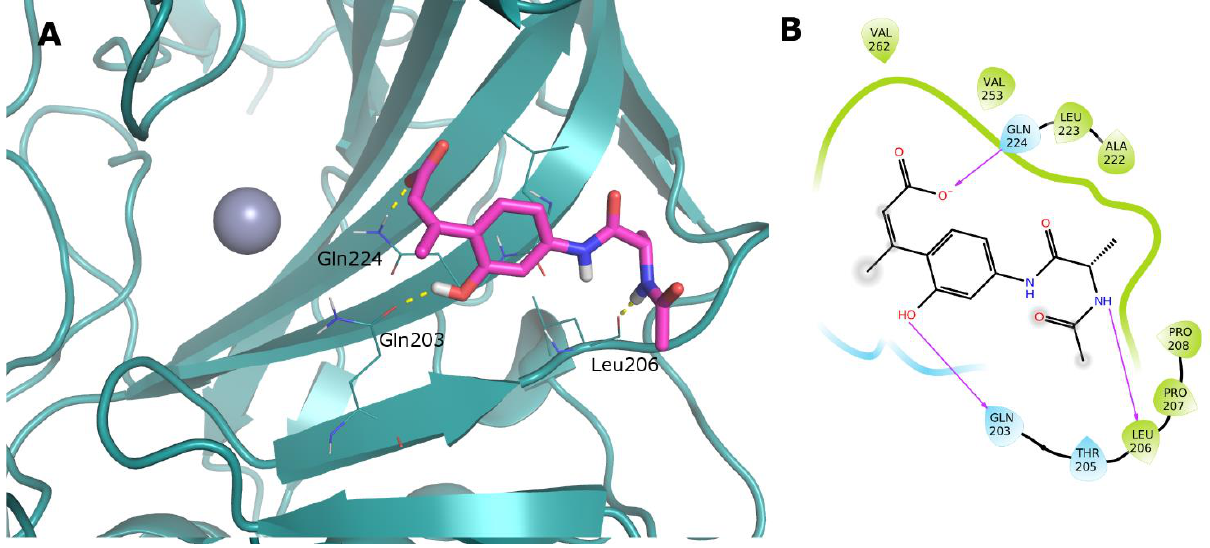
Figure 5. ( A ) Docked pose of ligand 6 (stick, magenta C atoms) in the hydrolyzed Z form in the hCA IX binding site (cartoon, dark cyan). ( B ) Corresponding 2D ligand interaction diagram.